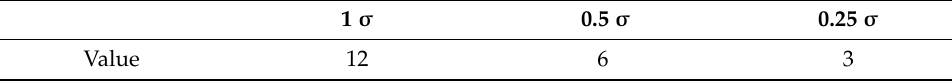
Table 3. Absolute error threshold for n σ .